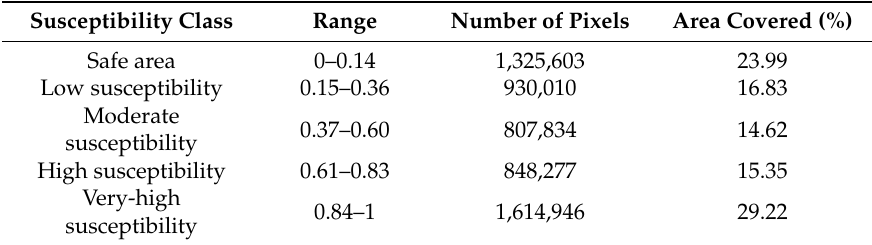
Table 5. Classification of desertification susceptibility map into five classes.